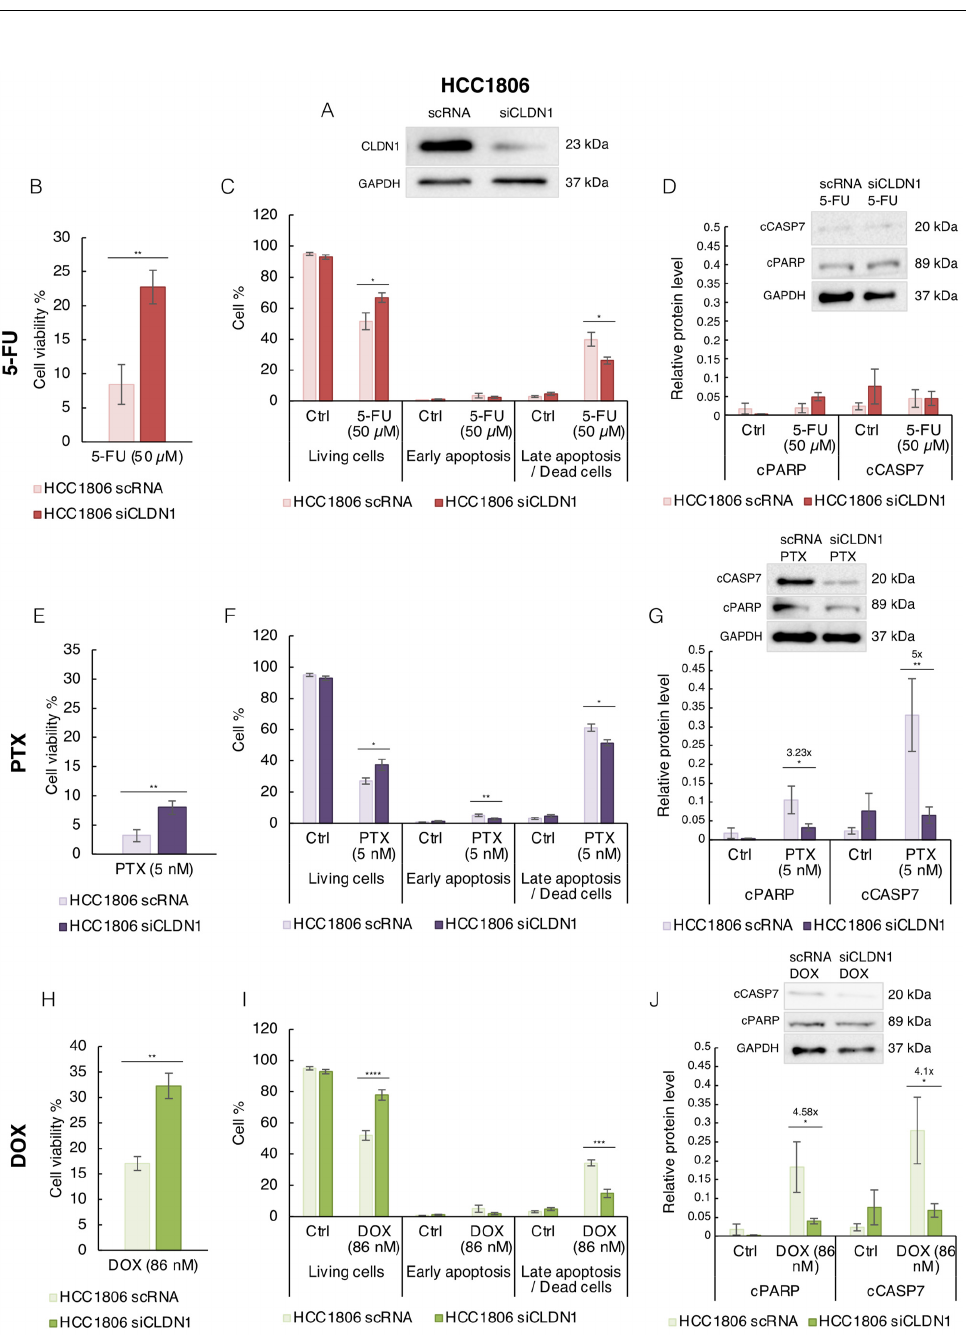
Figure 4. CLDN1 is involved in the chemosensitivity of HCC1806 “claudin-1-high” cells to 5-FU, PTX and DOX. ( A ) HCC1806 cells were transfected with siRNA directed against CLDN1 (siCLDN1) or with a scramble siRNA (scRNA) and CLDN1 expression was studied by western blot. 7 h after transfection, cells were treated for 72 h with ( B – D ) 50 µM of 5-FU, ( E – G ) 5 nM of PTX and ( H – J ) 86 nM of DOX or with solvent (Ctrl). ( B , E , H ) Cell viability percentage was determined by ATP level measurement and results were expressed as a percentage of the control exposed to the solvent. ( C , F , I ) HCC1806 cells were co-labeled with annexin V coupled to FITC and with propidium iodide and the living, early- and late-apoptotic cells were analyzed by flow cytometry. ( D , G , J ) Apoptosis was also analyzed by Western blot by studying the cleavage of PARP-1 (cPARP) and caspase 7 (cCASP7) markers. Relative protein level expressions correspond to the protein of interest on GAPDH ratios. The values represent the means ± SEM of four to eight different experiments. A p -value of less than 0.05 was considered statistically significant with * p < 0.05, ** p < 0.01, *** p < 0.001, **** p < 0.0001. The uncropped blots are shown in File